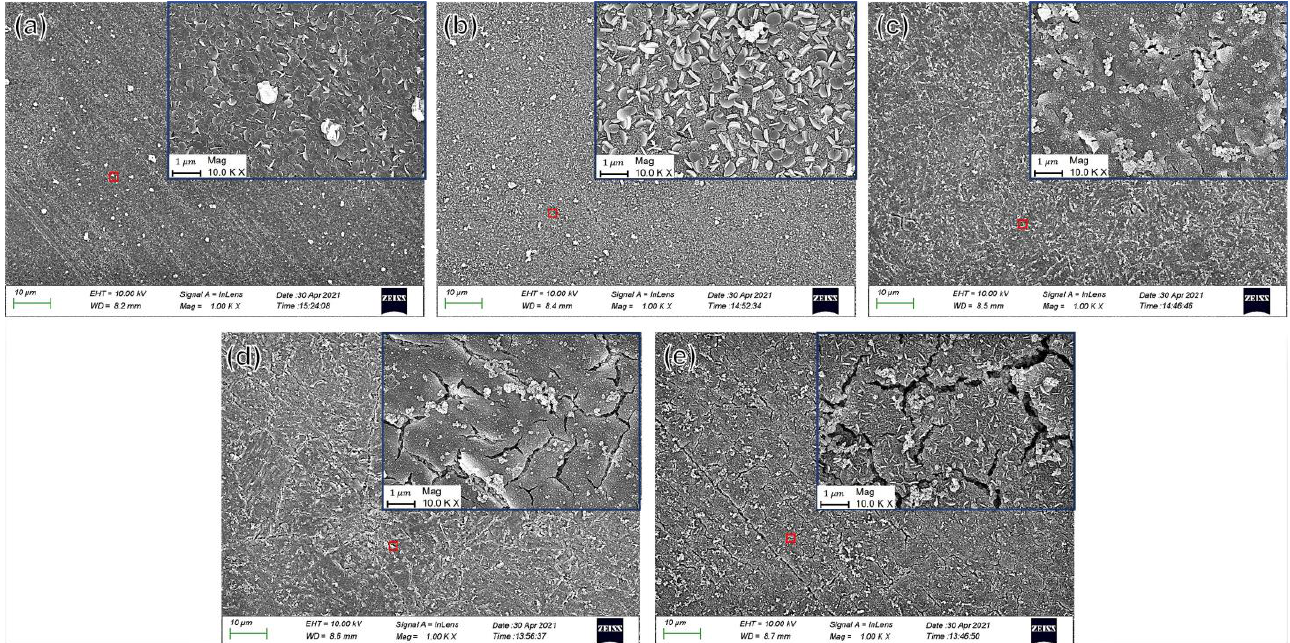
Figure 10. SEM corrosion product image of X80 steel sample after 2 h in NS4 solution under various DC densities with strain of 3 × 10 −3 : ( a ) i DC = 0 mA/cm 2 , ( b ) i DC = 0.25 mA/cm 2 , ( c ) i DC = 0.5 mA/cm 2 , ( d ) i DC = 1 mA/cm 2 , ( e ) i DC = 2 mA/cm 2 .